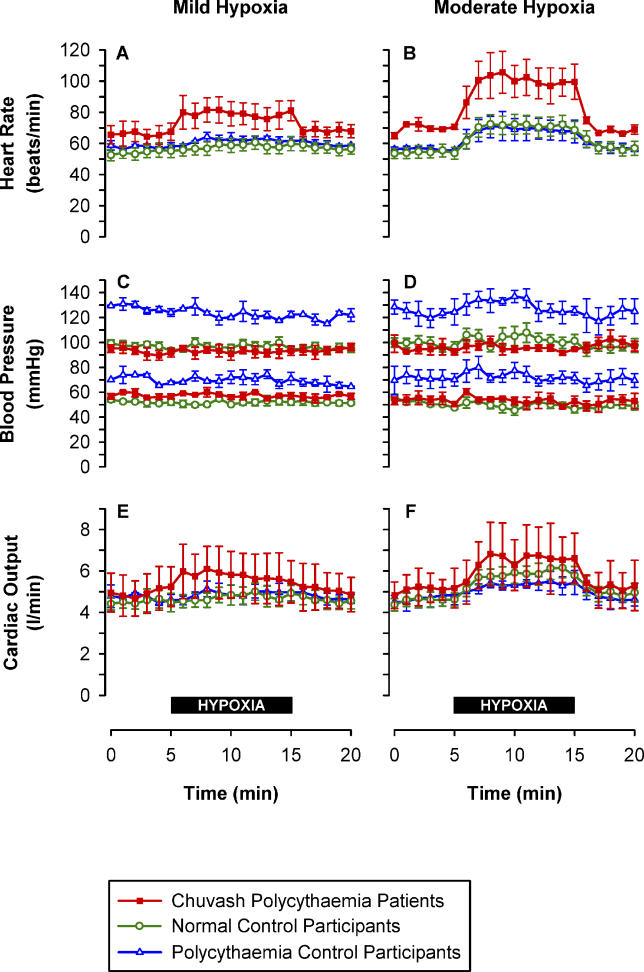
Systemic Vascular Responses to Mild and Moderate Hypoxia(A and B) Heart rate. Mild hypoxia provoked a rise of 11.7 beats/min in the CP patient group, compared with 3.6 beats/min in normal control participants (
p < 0.05). No other statistically significant differences in systemic vascular responses were detected between these two groups.
(C and D) Blood pressure, showing systolic pressure (upper plot) and diastolic pressure (lower plot).(E and F) Cardiac output, assessed non-invasively using Doppler echocardiography.All responses are shown during mild (A, C, and E) and moderate (B, D, and F) hypoxia. Values are mean ± standard error of the mean.